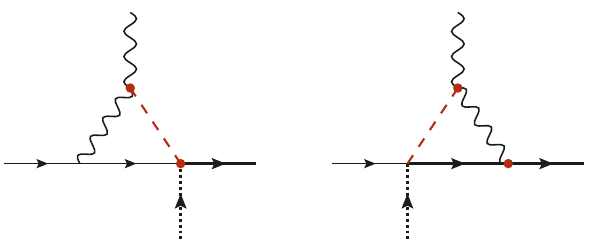
Figure 3 . Representative one-loop Feynman diagrams with ALP exchange (red dashed line), which require operators in the class ψ 2 XH as counterterms. Thick (thin) solid lines represent left-handed fermion doublets (right-handed fermion singlets). If the right-handed fermion is an up-type quark, the arrows on the Higgs lines need to be reversed.